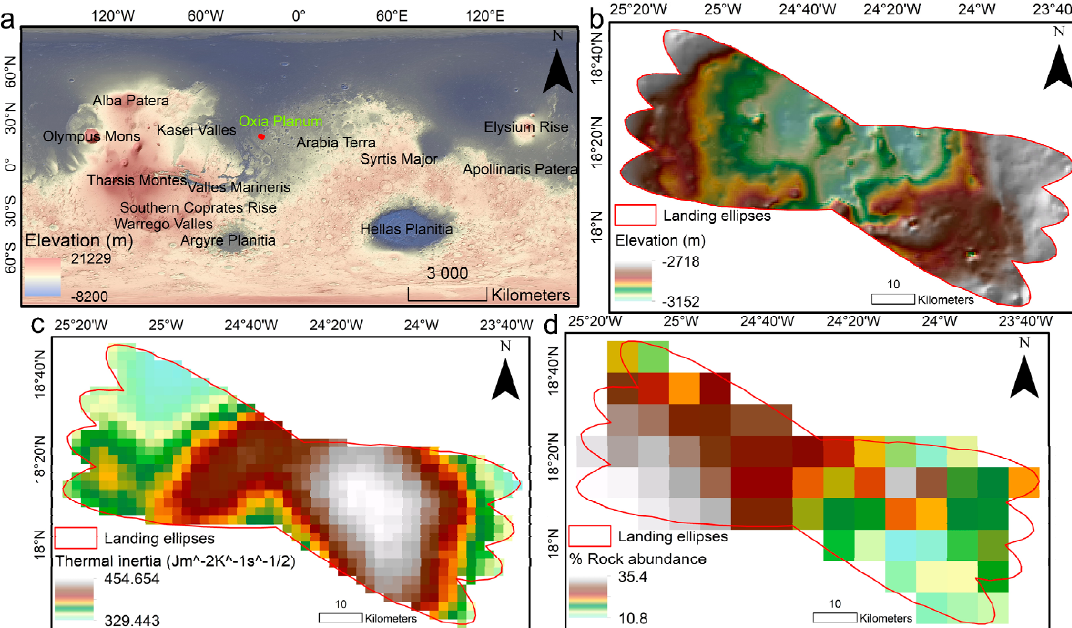
Figure 1. Oxia Planum as the study site for ExoMars 2020 landing. ( a ) Mars Orbiter Laser Altimeter (MOLA)-derived topography map of Mars showing location of Oxia Planum as the red dot (MOLA data courtesy: NASA / JPL / Goddard). ( b ) MOLA topography of Oxia Planum within expected landing ellipses (3- σ ) [34]. ( c ) Mars Global Surveyor (MGS) Thermal Emission Spectrometer (TES)-derived thermal inertia [36] for Oxia Planum landing ellipses. ( d ) TES-derived % rock abundance [37] map for Oxia Planum landing ellipses.